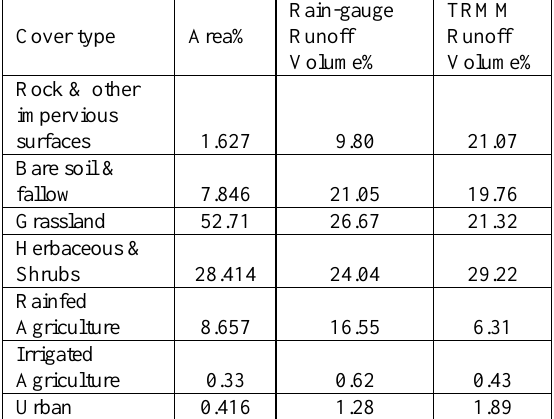
Table 3. Wadi El Hawad catchment runoff% based on rain- gauged and TRMM data